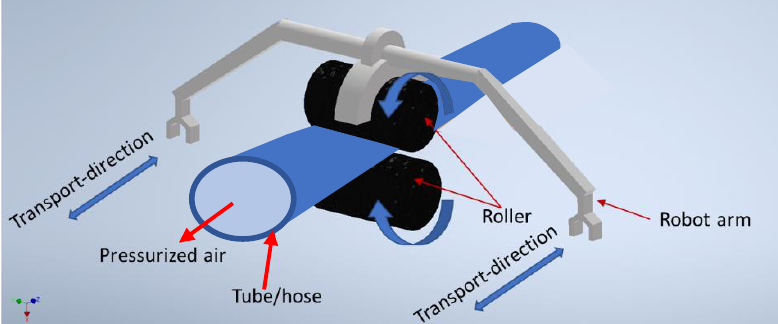
Figure 1. Schematic view of the working principle of PLPA.